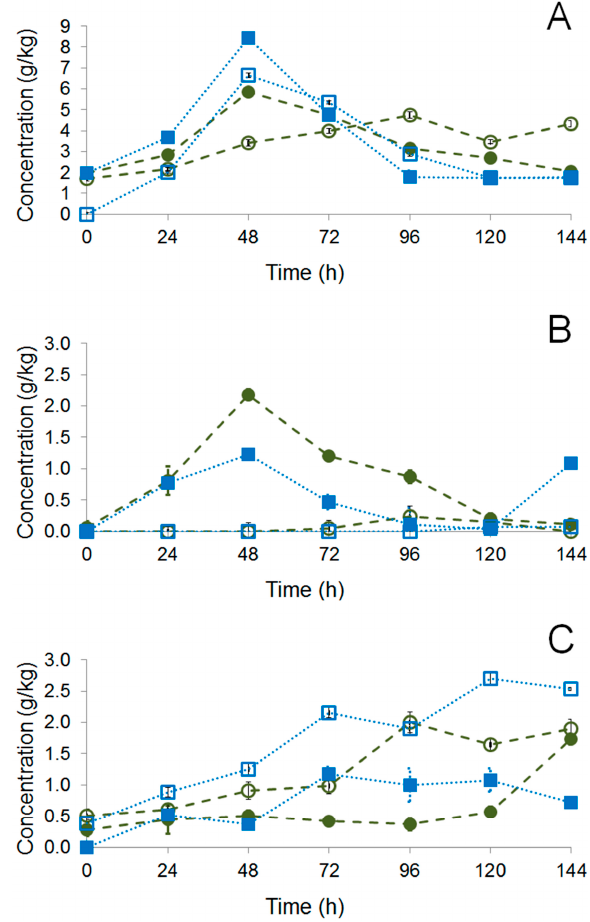
Figure 3. Detection by HPLC of ethanol ( A ); lactic acid ( B ); and acetic acid ( C ) during 144 h of fermentation of PH15 NI ( ) and PH15 I ( ); full symbols correspond to metabolites detected in the pulp while open symbols to those detected inside the beans.